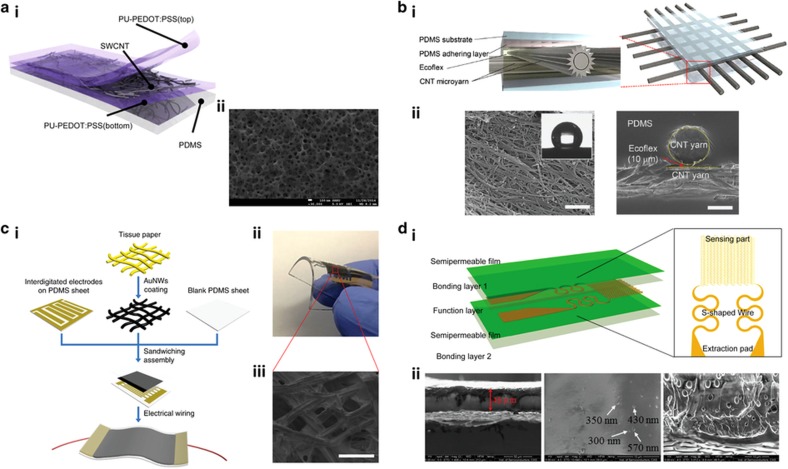
Solid-state physical sensing platforms. (a) Stretchable strain sensors based on the nanohybrid assembly of SWCNTs and PEDOT:PSS. (i) Schematic cross-section illustration of the device comprising stacked layers of PU-PEDOT:PSS, SWCNT, and PEDOT:PSS on a PDMS elastomer. (ii) Scanning electron microscope (SEM) image showing the top view of the three-layer nanohybrid strain sensor. Adapted with permission from Ref. 34. Copyright 2015 American Chemical Society. (b) All-carbon multimodal piezocapacitive stretchable skin sensor. (i) Schematic illustration showing the active layers of the hierarchically engineered CNT microyarn-based sensor. (ii) SEM image of the surface of the CNT microyarns (left). Scale bar, 1 μm. Inset shows the hydrophobic nature of the surface. Cross-sectional SEM image of the CNT microyarn-incorporated layered structure (right). Scale bar, 50 μm. Adapted with permission from Ref. 35. Copyright 2015 Wiley-VCH Verlag GmbH & Co. (c) AuNW-coated tissue paper-based flexible pressure sensor. (i) Schematic illustration showing the fabrication process of the pressure sensor. (ii) Optical image showing the flexibility of the fabricated device. (iii) SEM image showing the surface morphology of the AuNW-coated tissue paper. Scale bar 100 μm. Adapted with permission from Ref. 3. Copyright 2014 Macmillan Publishers Limited. (d) Stretchable and breathable skin-inspired temperature sensor. (i) Device architecture of the temperature sensor. (ii) SEM image showing the cross-section of the semipermeable PU film (left), the surface of the semipermeable PU film (center), and the microstructure of the PU layer of the semipermeable membrane. Adapted with permission from Ref. 101. Copyright 2015 Macmillan Publishers Limited. AuNW, Au nanowire; CNT, carbon nanotubes; PU, polyurethane; SEM, scanning electron microscope; SWCNTs, single-walled CNTs.